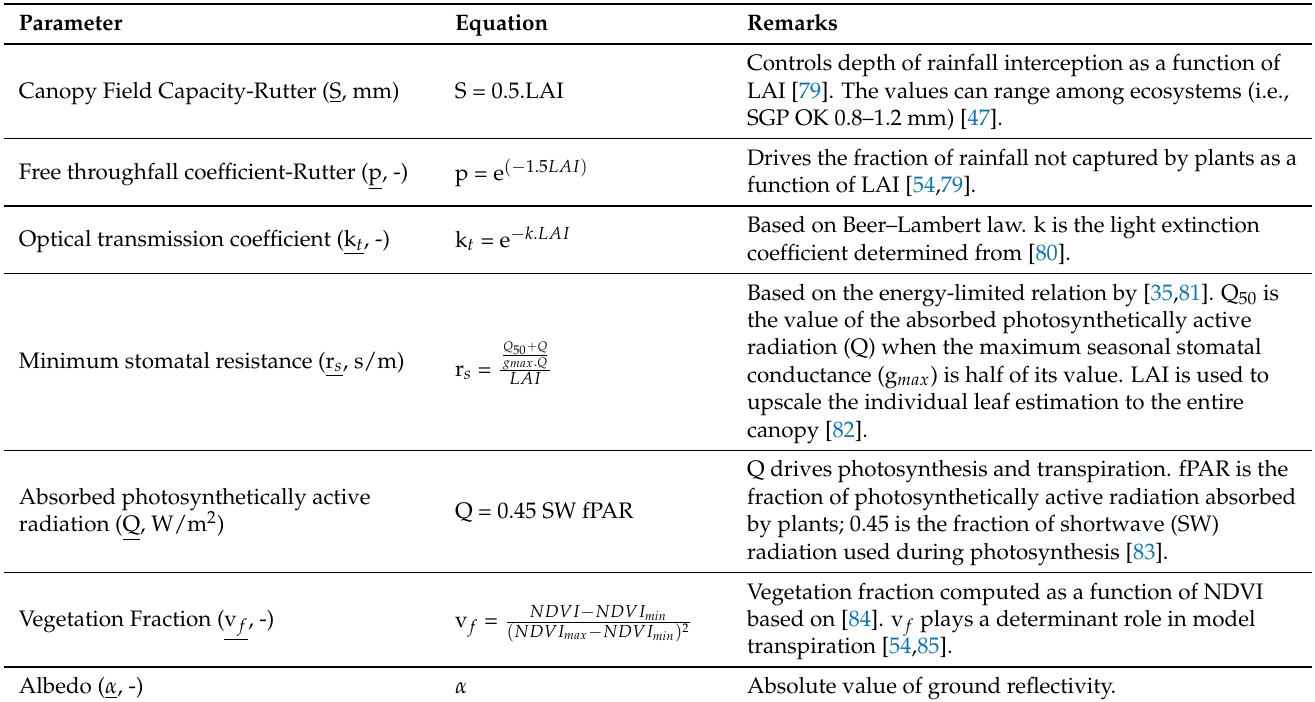
Table 6. Physics-based equations linking remote sensing with tRIBS dynamic vegetation